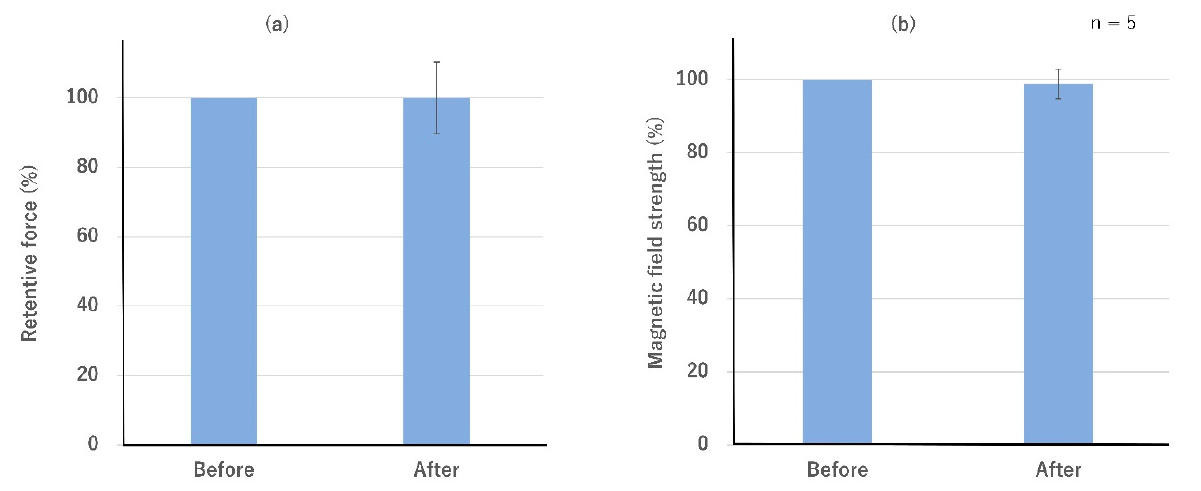
Figure 5. Comparison of ( a ) retentive force and ( b ) magnetic field strength after load test (means and standard deviations). No change was observed.